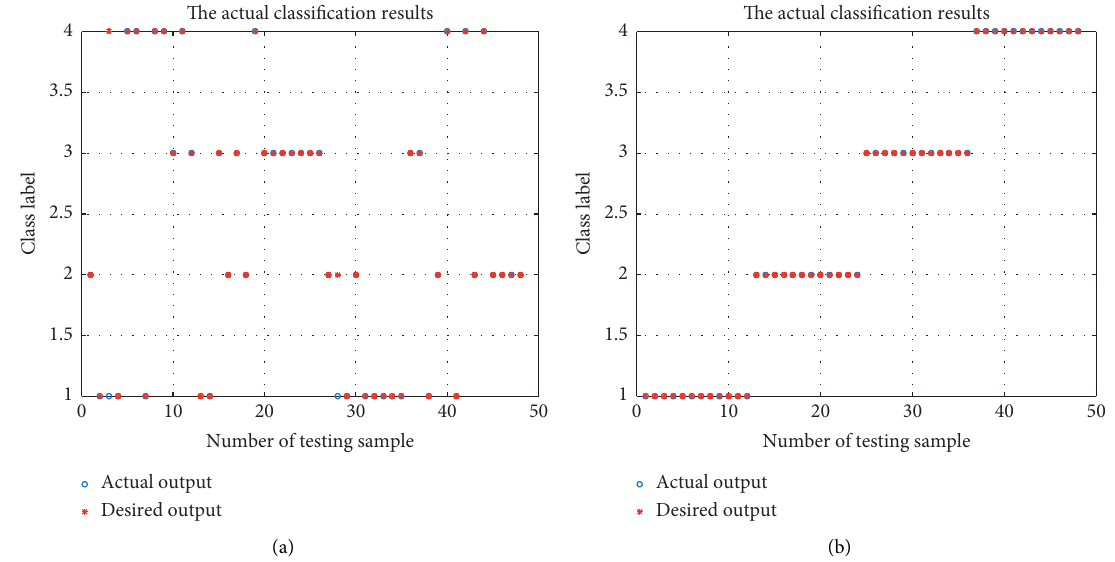
Figure 16: Recognition result of the experimental signal based on time-domain energy entropy. (a) SVM model. (b) PSO-SVM model.